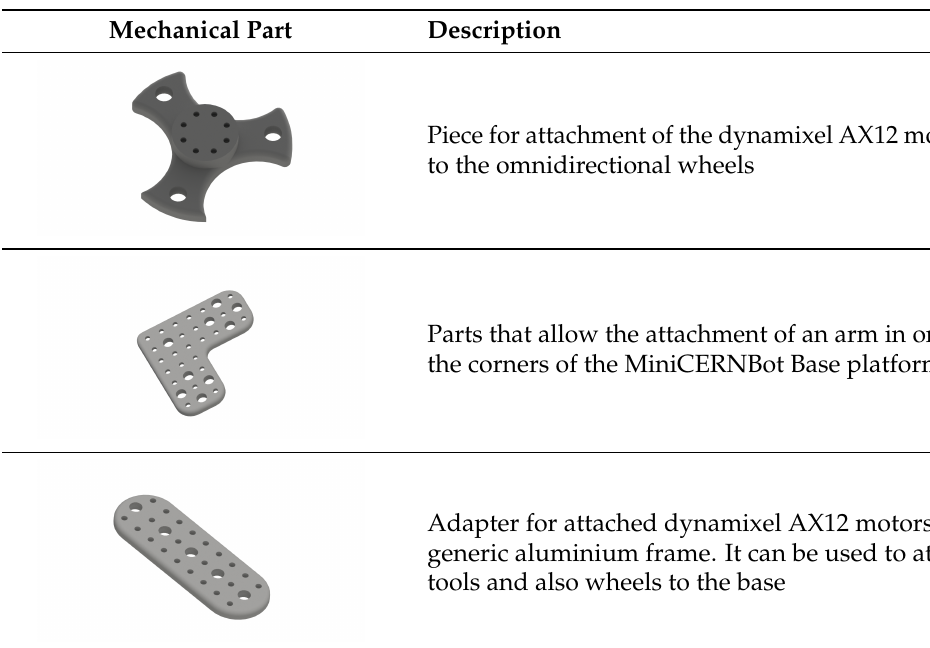
Table 2. Examples of mechanical parts available at the MiniCERNBot